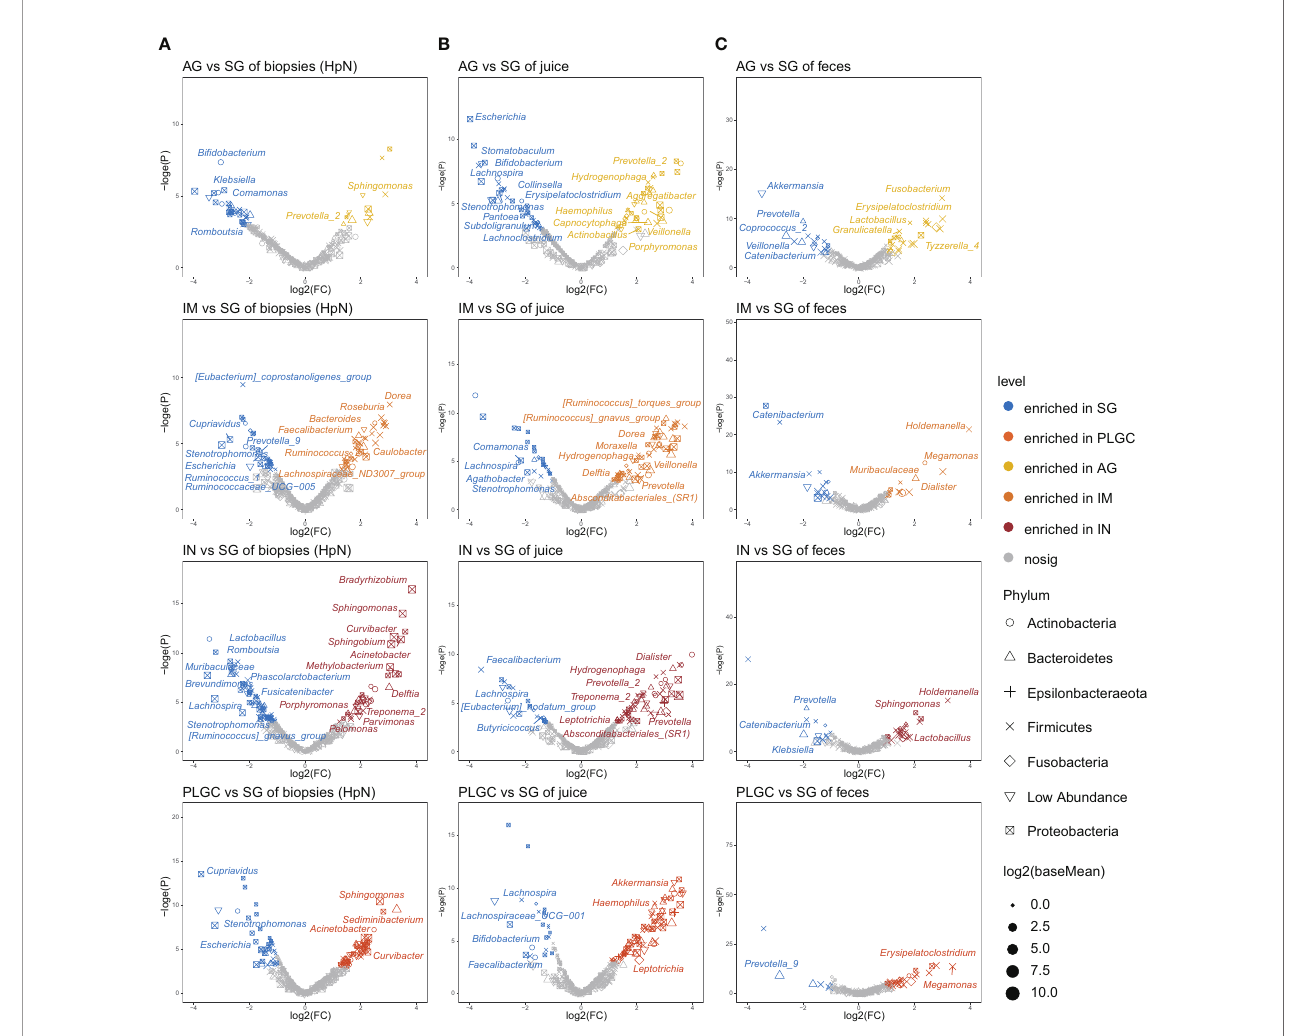
FIGURE 4 | Speci fi c bacterial taxa associated with PLGC. (A) Signi fi cantly changed mucosal bacteria in different PLGC subgroups of H. pylori -negative subjects. (B) Signi fi cantly changed bacteria in diagnosis groups of gastric juices and (C) stool samples.